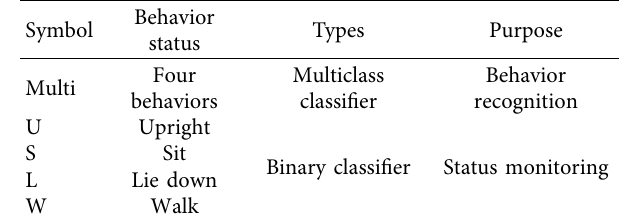
Figure 3: The user behavior sensing model. Table 1: Multimodal sensor category.